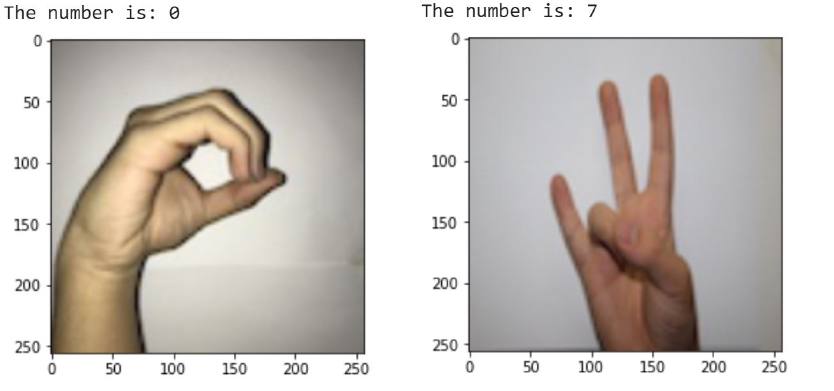
Figure 9. Predictions (given on top of images) of the proposed CNN in classifying the given test samples from the sign dataset.